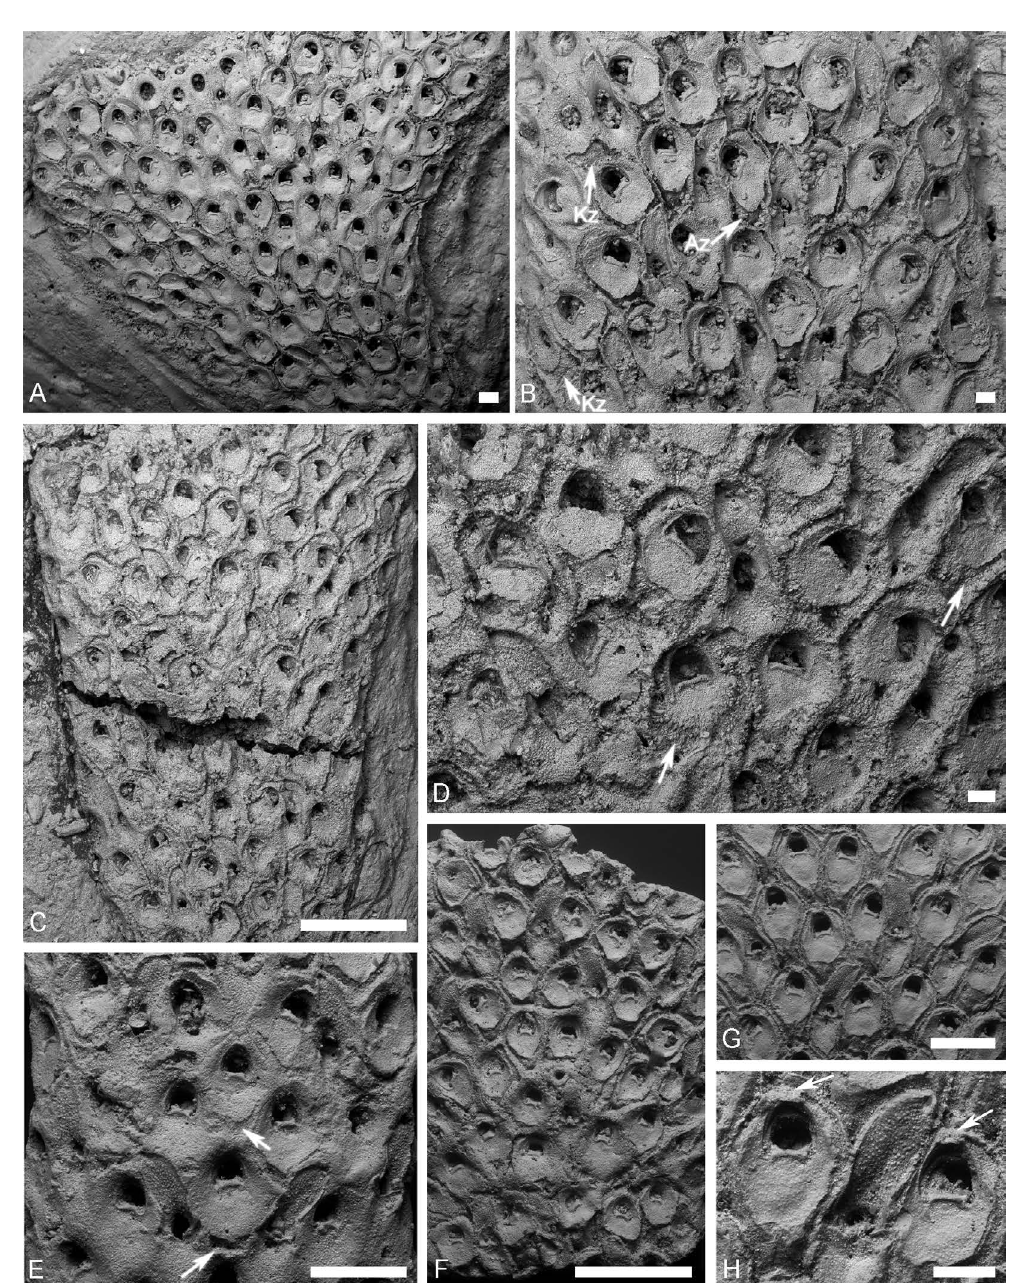
Fig. 5. Rhagasostoma brydonei sp. nov. A–D . Latest Turonian ( Sternotaxis plana Zone), Kings Lane, Froxfield, south of Alton, Hampshire, England, UK. A–B . Holotype, SM B36666. A . Overview of erect bifoliate colony. B . Autozooids (Az) and kenozooids (Kz) with peripheral caverns (arrowed) and avicularia. C–D . Paratype SM B36667. C . Overview of erect bifoliate colony. D . Autozooids with peripheral cavern surrounding the cryptocyst (arrowed) and avicularia. E–H . Coniacian, Chatham, Kent, England, UK. E . Paratype, SMF 29940, autozooids with proximal peripheral caverns (arrowed) and avicularia. F . Paratype, SMF 29939, autozooids with peripheral cavern surrounding the cryptocyst and avicularia. G–H . Paratype, SMF 29941. G . Autozooids with peripheral cavern surrounding the cryptocyst and avicularia. H . Autozooids with peripheral cavern surrounding the cryptocyst and ooecia of immersed ovicells (arrowed) and avicularia. Scale bars: A, D, H = 200 µm; B = 100 µm; C, F = 1 mm; E, G = 500